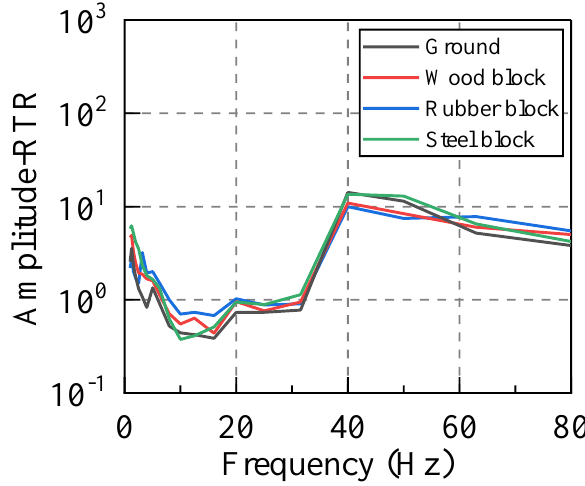
Figure 9. Amplitude − RTR. (Different cushion blocks).